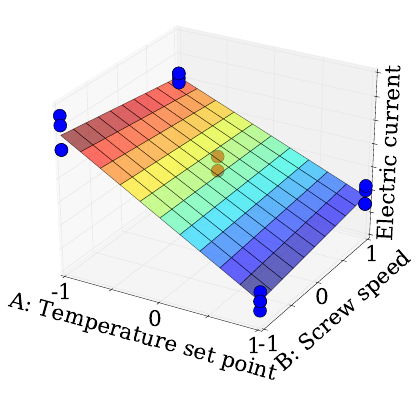
Figure 4: Mass pressure response surface